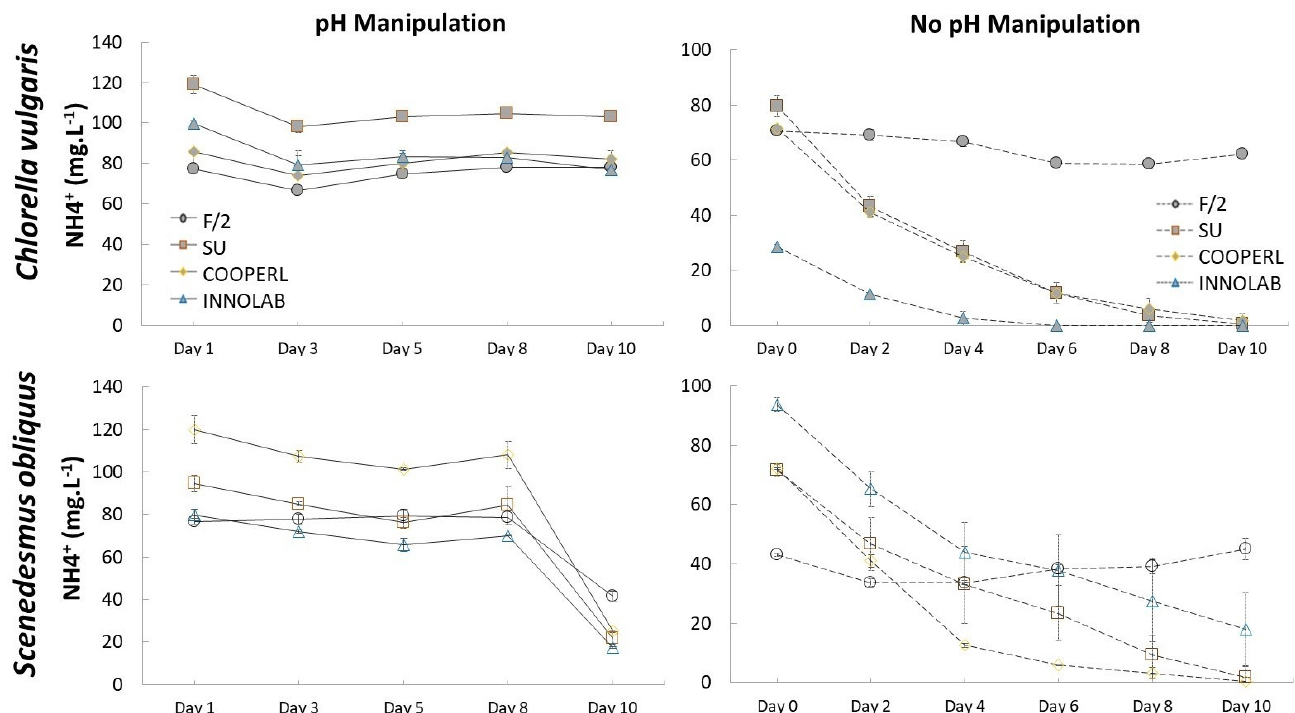
Figure 3. Concentration of ammonium NH 4+ in cultures of C. vulgaris and S. obliquus grown on three different digestates under pH manipulation and no pH manipulation for 10 days of experiment. Error bars represent the standard deviation on three replicates.